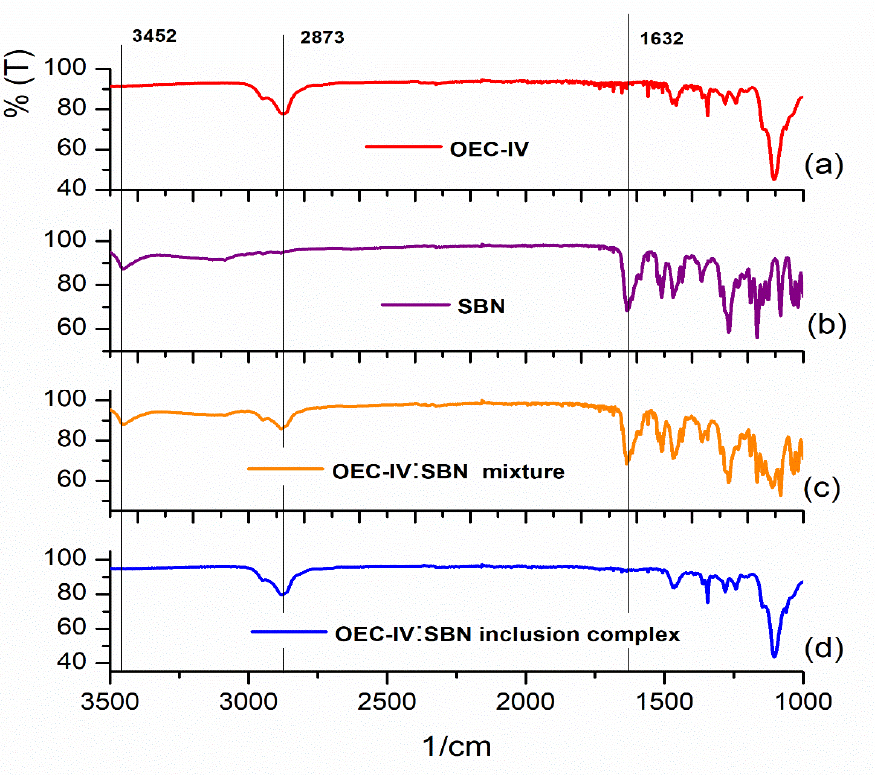
Figure 6. FT-IR spectra in the region 1000–3000 cm − 1 of ( a ) OEC-IV, ( b ) silibinin, ( c ) the OEC- IV:silibinin physical mixture and ( d ) the OEC-IV:silibinin inclusion complex.